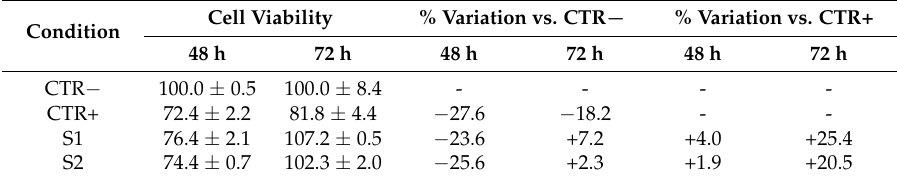
Table 2. Cell viability (MTT test) of CTR − , CTR+, S1 and S2 at 48 and 72 h. Condition